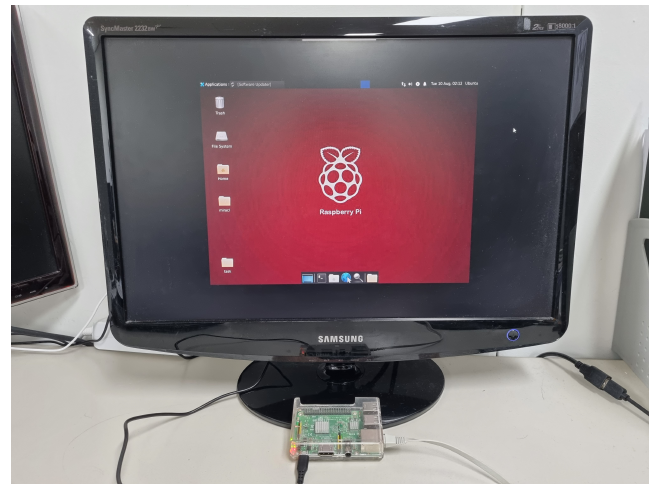
Figure 8. Raspberry Pi Platform.